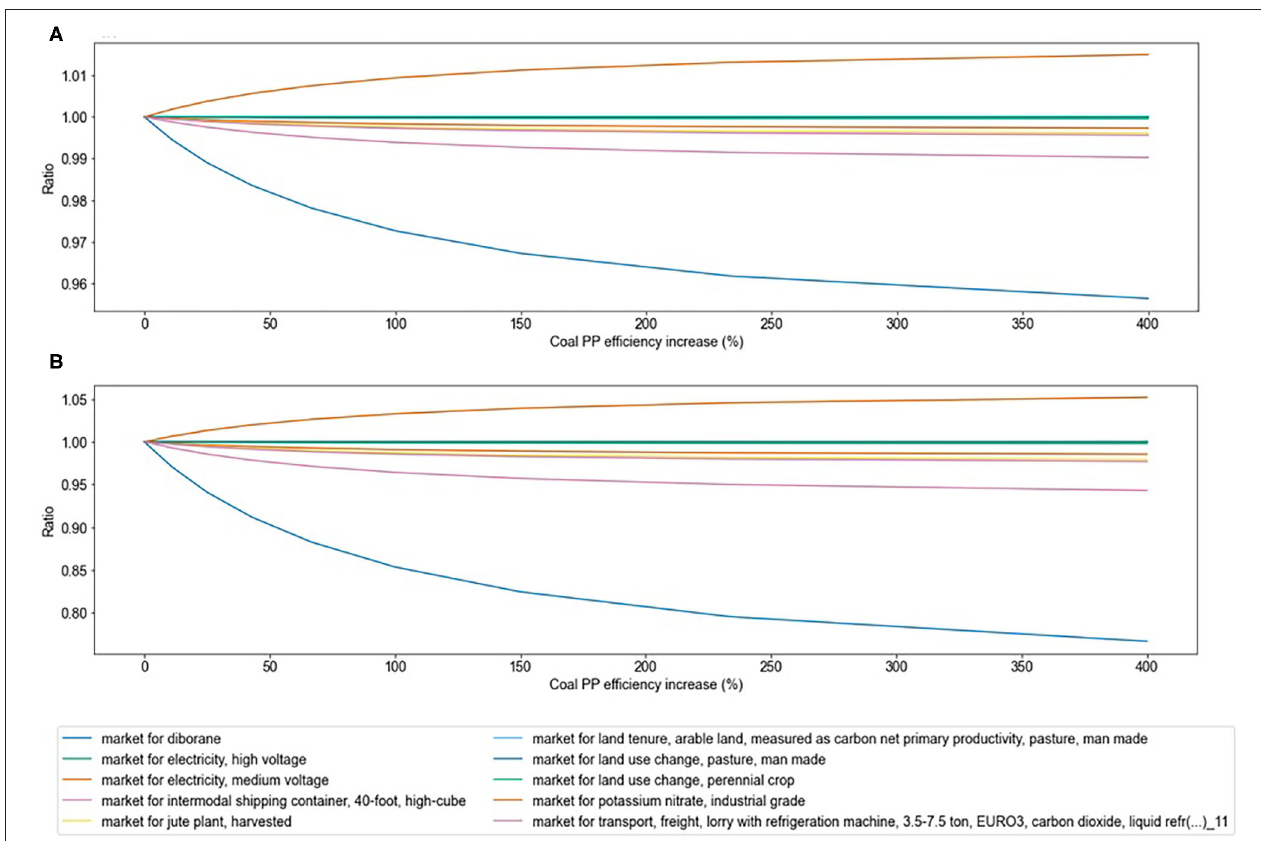
FIGURE 1 | Effect of improving from 0–400% the efficiency of electricity production in all coal-based power plants datasets of the ecoinvent database (consequential) on the Global Warming impact calculated for 10 randomly selected activities from same database. The effect is expressed as the ratio between the impact of the improved dataset and the impact of the unmodified dataset: values closer to 1 indicate a weaker effect. (A) shows the effect of improving only technosphere exchanges, while (B) the effect of improving both technosphere and biosphere